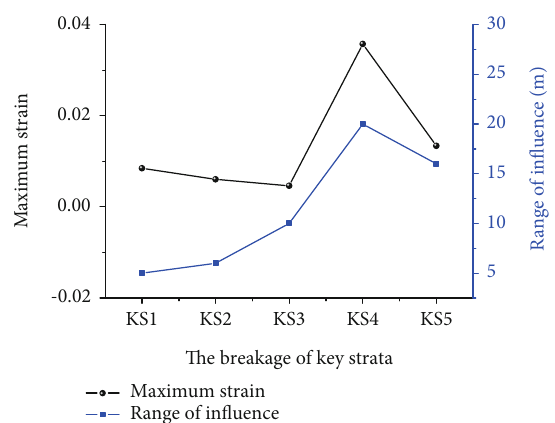
Figure 6: E ff ect on the coal body of fracturing of di ff erent levels of hard